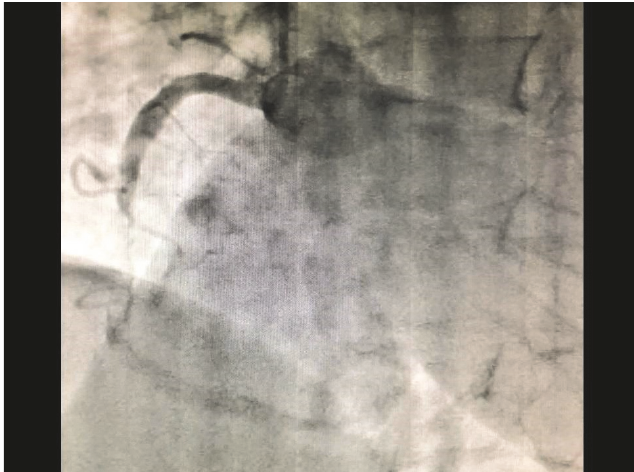
Figure 2: Emergency coronary angiography (CAG). CAG demonstrated 99% stenosis at section #2, and complete occlusion at section